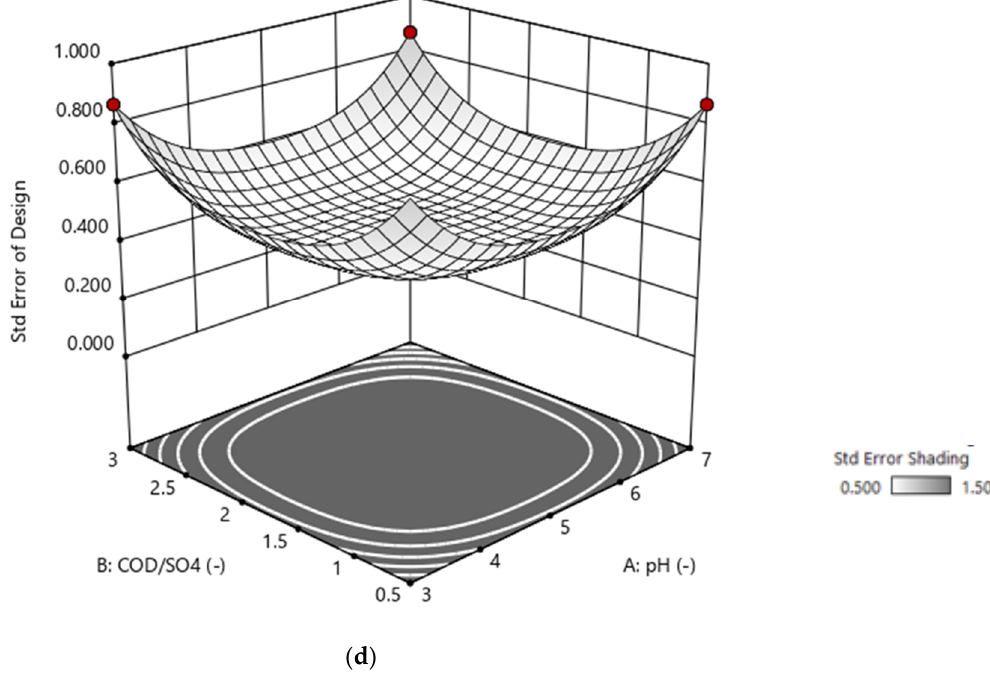
Figure 3. ( a ) Normal probability plot of residuals, ( b ) residuals vs. predicted, ( c ) predicted vs. actual output of the model, and ( d ) 3-D standard error plot for sulphate removal.